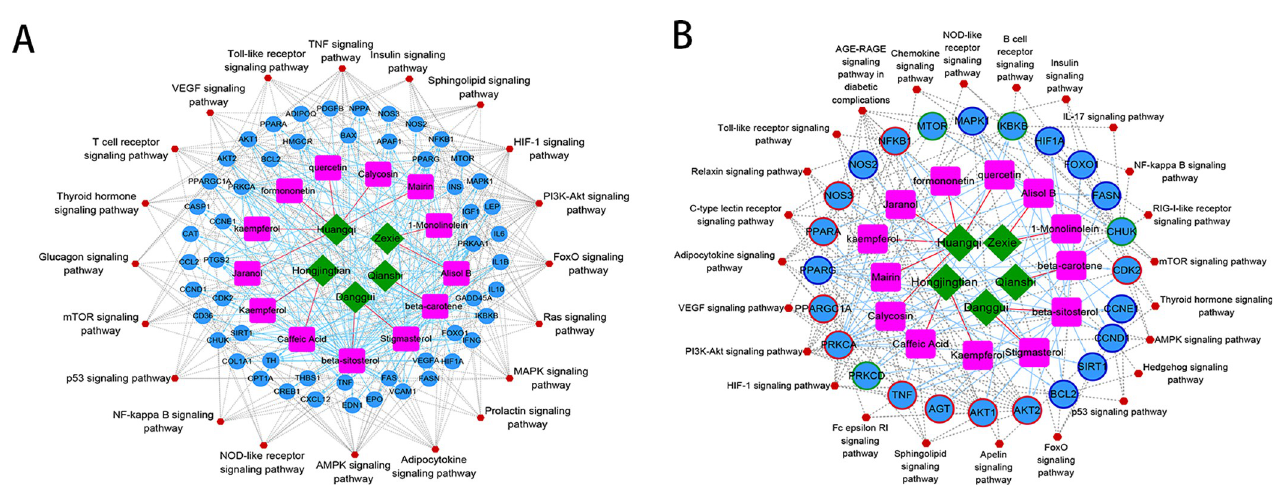
Fig 4. The pharmacological networks for (A) cross-validation targets; (B) cross-validation targets in the protein–protein interaction network. The green rhombus represents herbal medicine; the pink square represents components; the blue dots represent targets; the red hexagon represents the pathways.